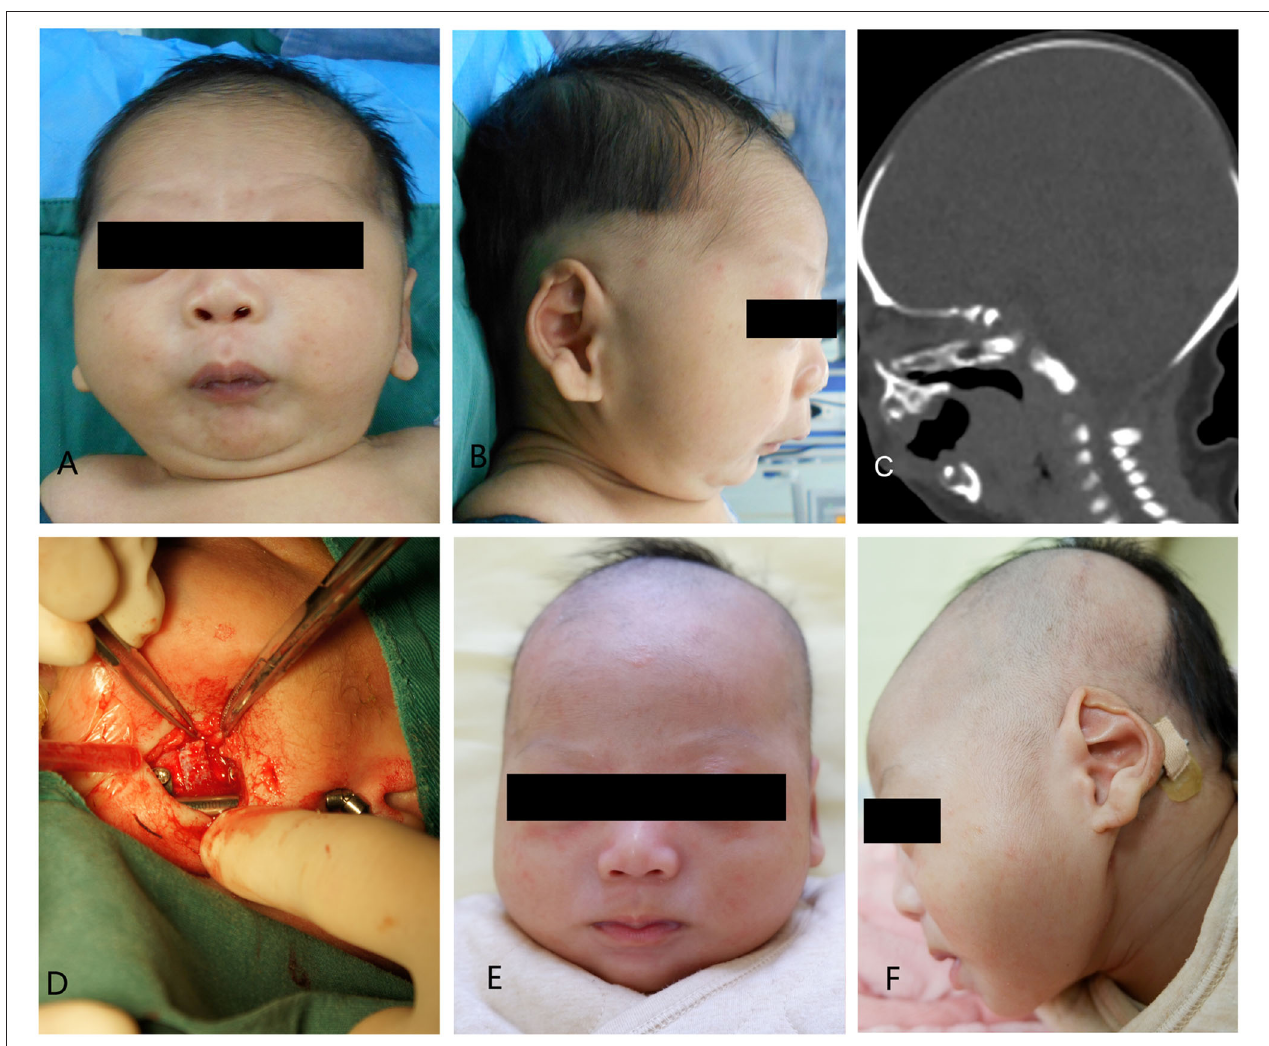
FIGURE 4 | Case 1. (A) A preoperative frontal view. (B) Preoperative lateral view. (C) Preoperative CT-scan. (D) Intraoperative situation. (E) Postoperative anteroposterior view. (F) Postoperative lateral